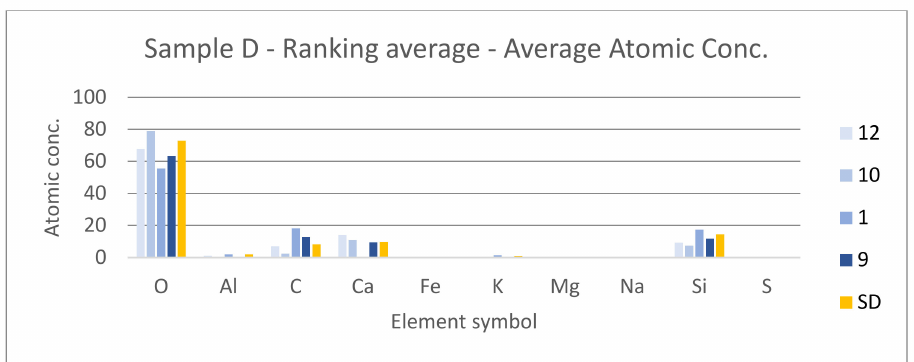
Figure 24. Sample D—ranking average—average atomic concentration.